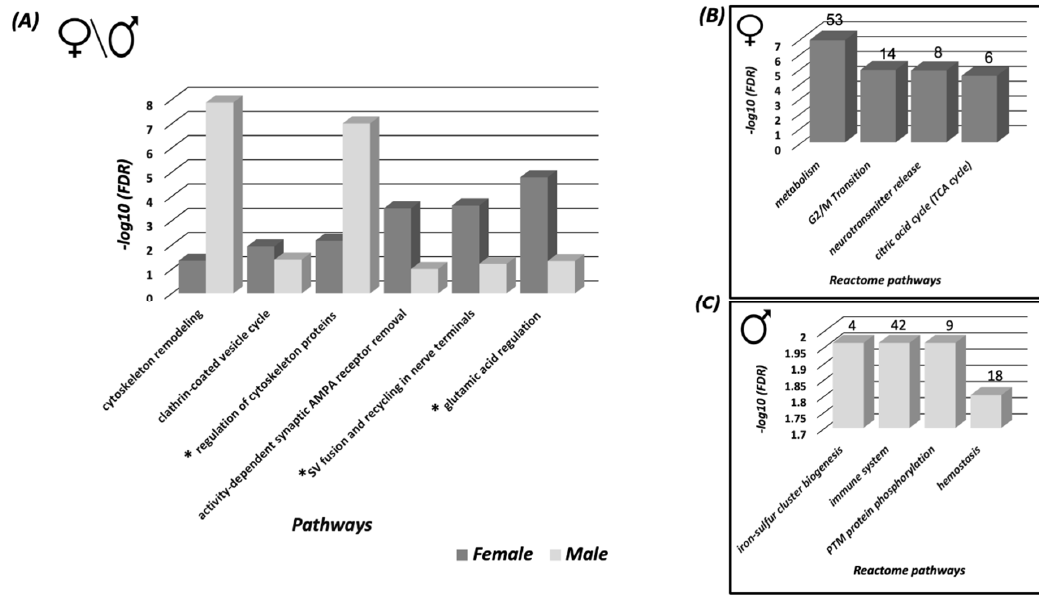
Figure 2. Pathways and interactome analysis of the exclusive SNO proteins in the female and male cortices. ( A ) Pathways analysis of the SNO proteins that are exclusive to female and male cortices. cortex and ( C ) the male cortex. The number of the SNO proteins in each pathway is presented above each bar. Each bar represents the − log10 of the FDR value. Abbreviations: * Regulation of cytoskeleton proteins in oligodendrocyte di ff erentiation and myelination, * Synaptic vesicle fusion and recycling in nerve terminals, * Glutamic acid regulation of Dopamine D1A receptor signaling.